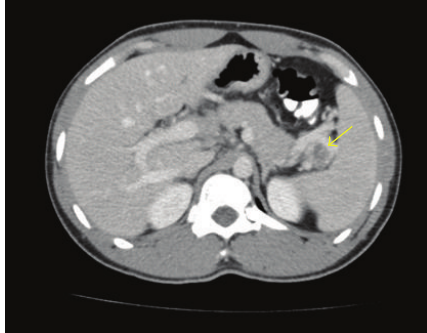
Figure 2: A complex cystic lesion with an internal septation in the splenic porta lying between the tail of the pancreas and the spleen (arrow).